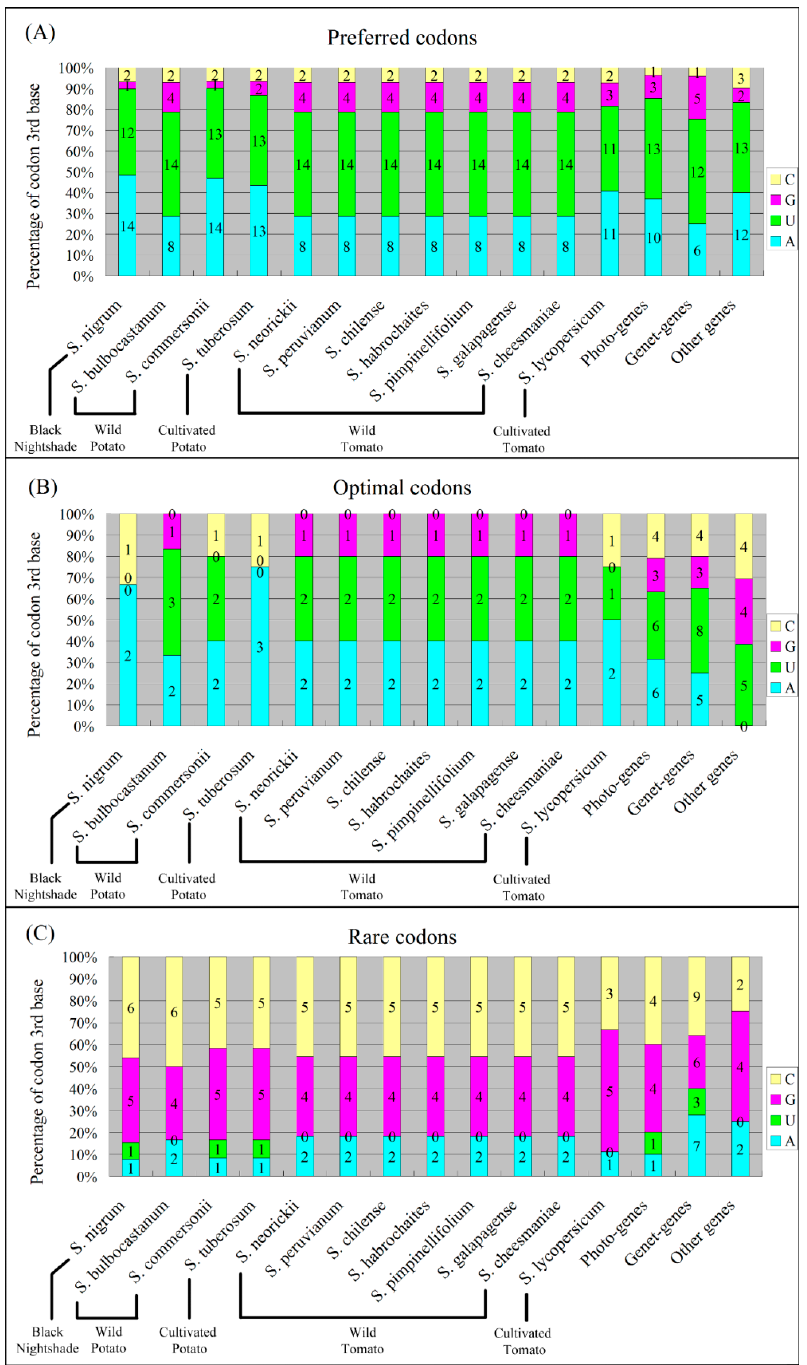
Figure 4. Preferred codons (A), optimal codons (B), and rare codons (C) at the third base of Solanum chloroplast genomes. The numbers of preferred codons (RSCU > 1), optimal codons (the usage frequency is significantly higher in high-expression genes than in low expression genes), and rare codons (RSCU < 0.1) were calculated according to Table 3 and Table S1. Cytosine (C), Guanine (G), Uracil (U), and Adenine (A) at the third base of codon were respectively shown in yellow, purple, green, and blue. For twelve Solanum chloroplast genomes, more than 78% preferred codons, more than 66% optimal codons, and less than 19% rare codons were A/U at the third codon position. For Photo-genes, 85% preferred codons, 63% optimal codons, and 20% rare codons ended in A or U. For Genet-genes, 75% preferred codons, 65% optimal codons, and 40% rare codons ended in A or U. For Other genes, 83% preferred codons, 38% optimal codons, and 25% rare codons ended in A or U.